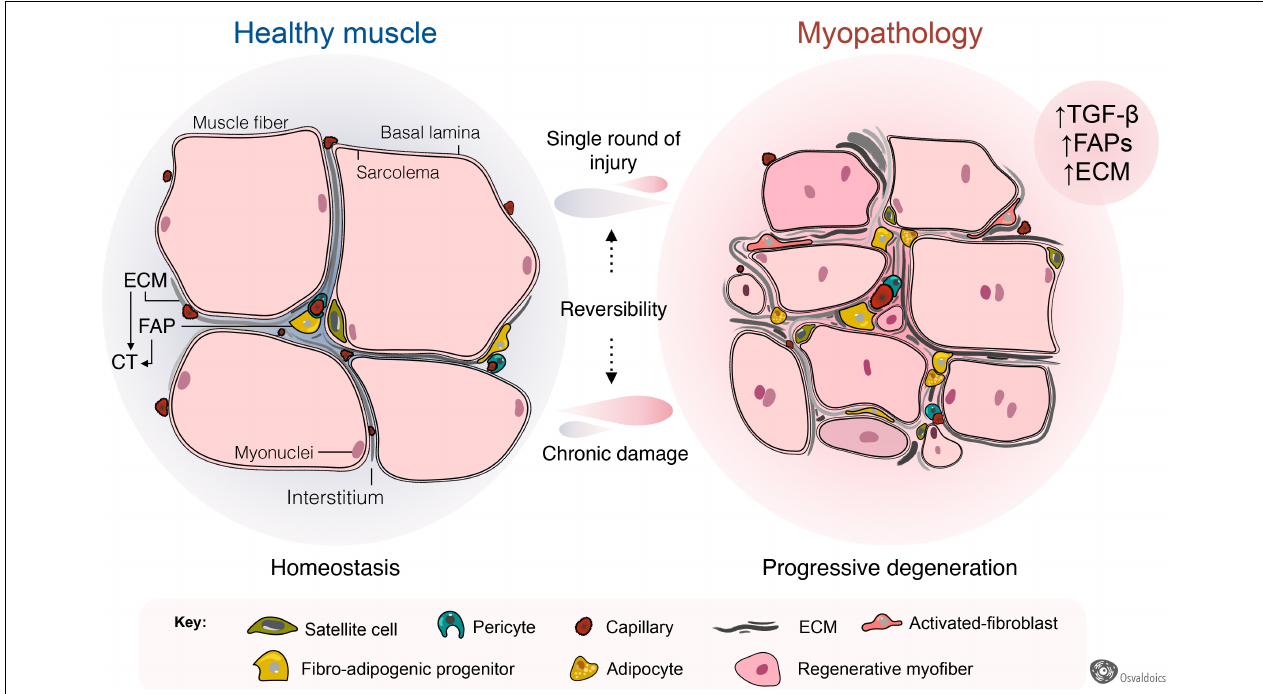
FIGURE 4 | Fibro-adipogenic progenitors as central drivers of muscle pathology and fibro-fatty infiltration. Skeletal muscles have high regenerative capabilities after a single round of injury, which progressively diminishes following chronic damage. Hence, chronic injury primes the tissue into a state of progressive degeneration. In homeostasis, a high proportion of fibro-adipogenic progenitors are perivascular cells and remain quiescent. Injury activates FAPs and induces their expansion and differentiation into several mesenchymal lineages, including activated fibroblasts, adipocytes, and bone-like cells. Activated FAPs and their lineage derived fibroblasts produce increased amounts of extracellular matrix (ECM), leading to connective tissue hyperplasia and poorer outcomes for patients. In several traumas and pathology, the adipogenic differentiation of FAPs also impairs muscle function and integrity. Muscle degeneration associates with an increased number of FAPs, activated TGF- β signaling and enhanced fibrosis. Chondrogenic and osteogenic FAP differentiation are not depicted to simplify the cartoon.